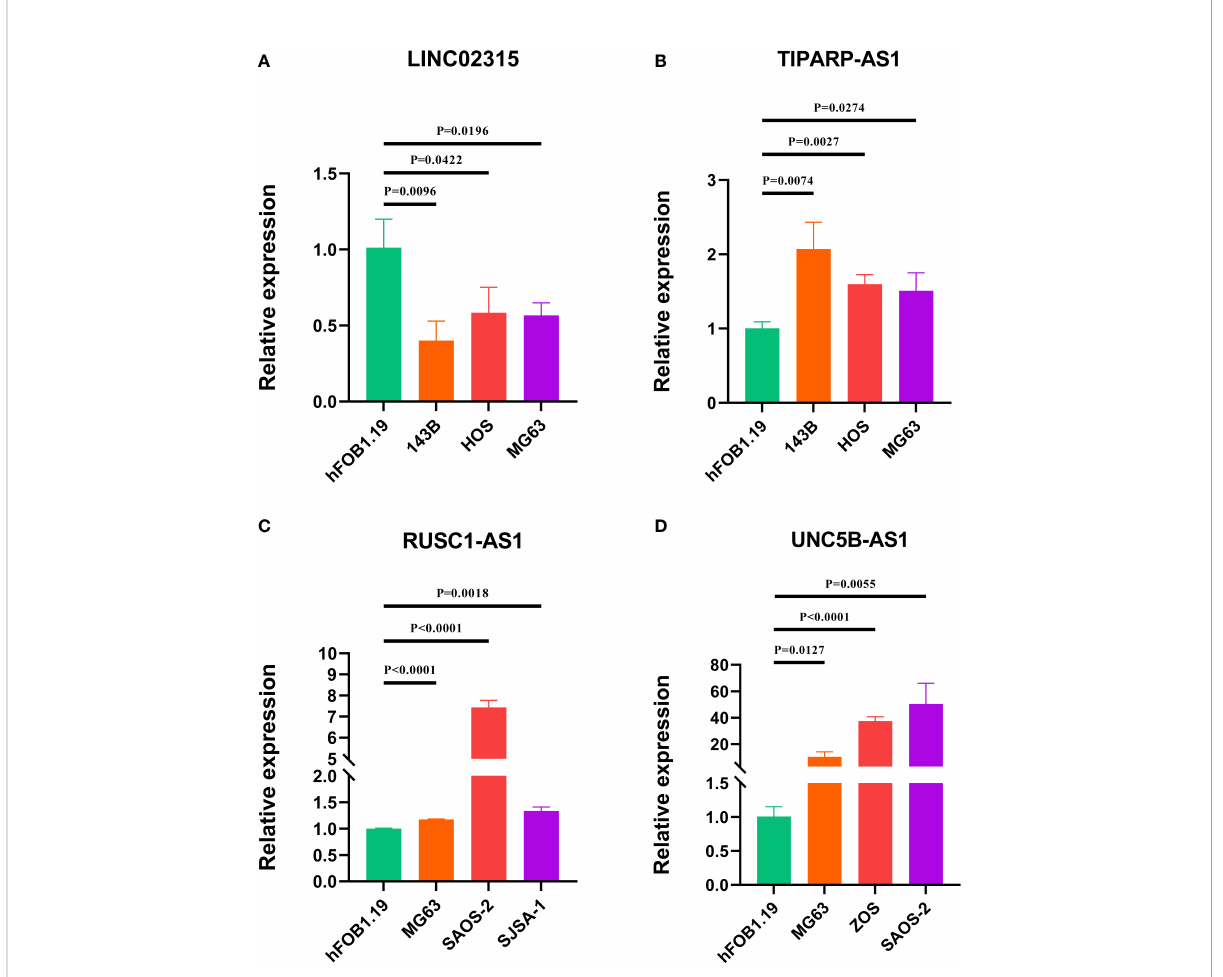
FIGURE 9 Veri fi cation of the expression of signature CRLs in OS cell lines by using RT-qPCR. (A) LINC02315. (B) TIPARP-AS1. (C) UNC5B-AS1. (D)